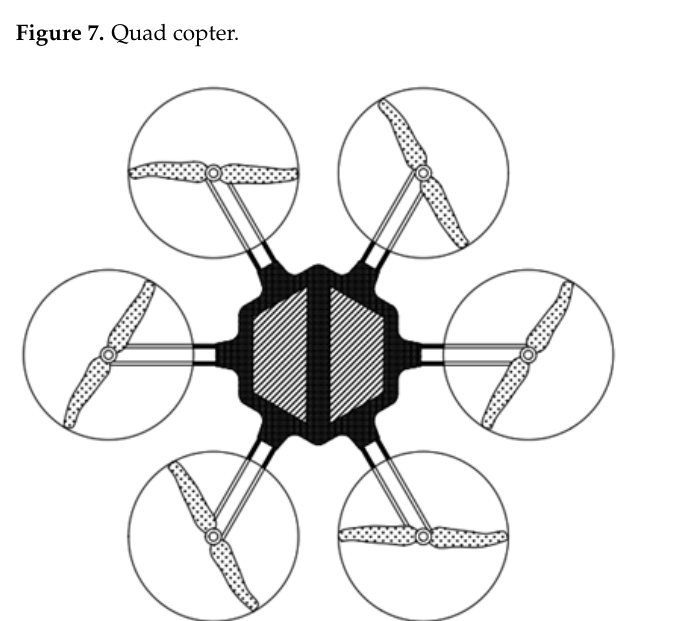
Figure 8. Figure 8. Hexacopter.